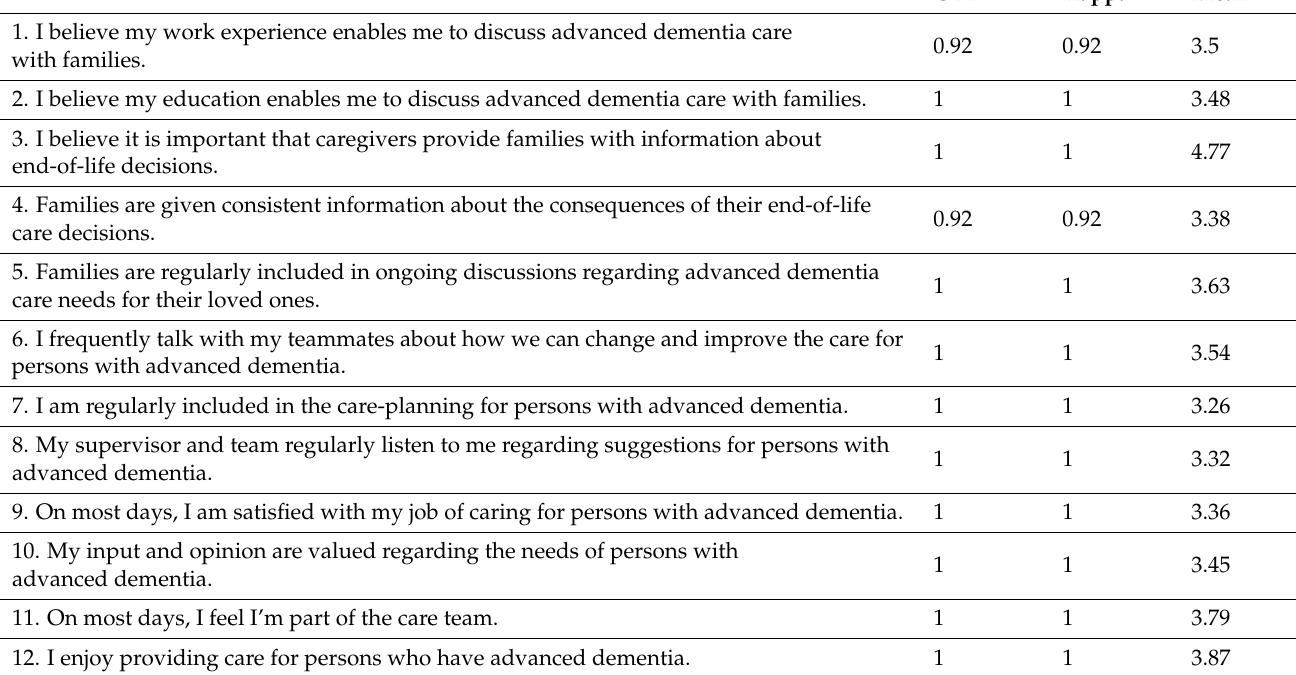
Table 2. Attitudes towards palliative care in advanced